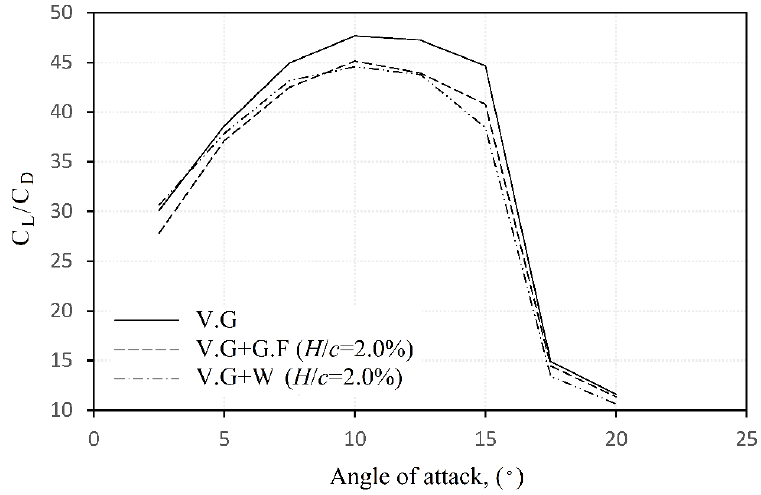
Figure 17. Comparison of aerodynamic performance of the airfoil equipped with VGs in the presence of Gurney flap and trailing-edge wedge at height of H / c